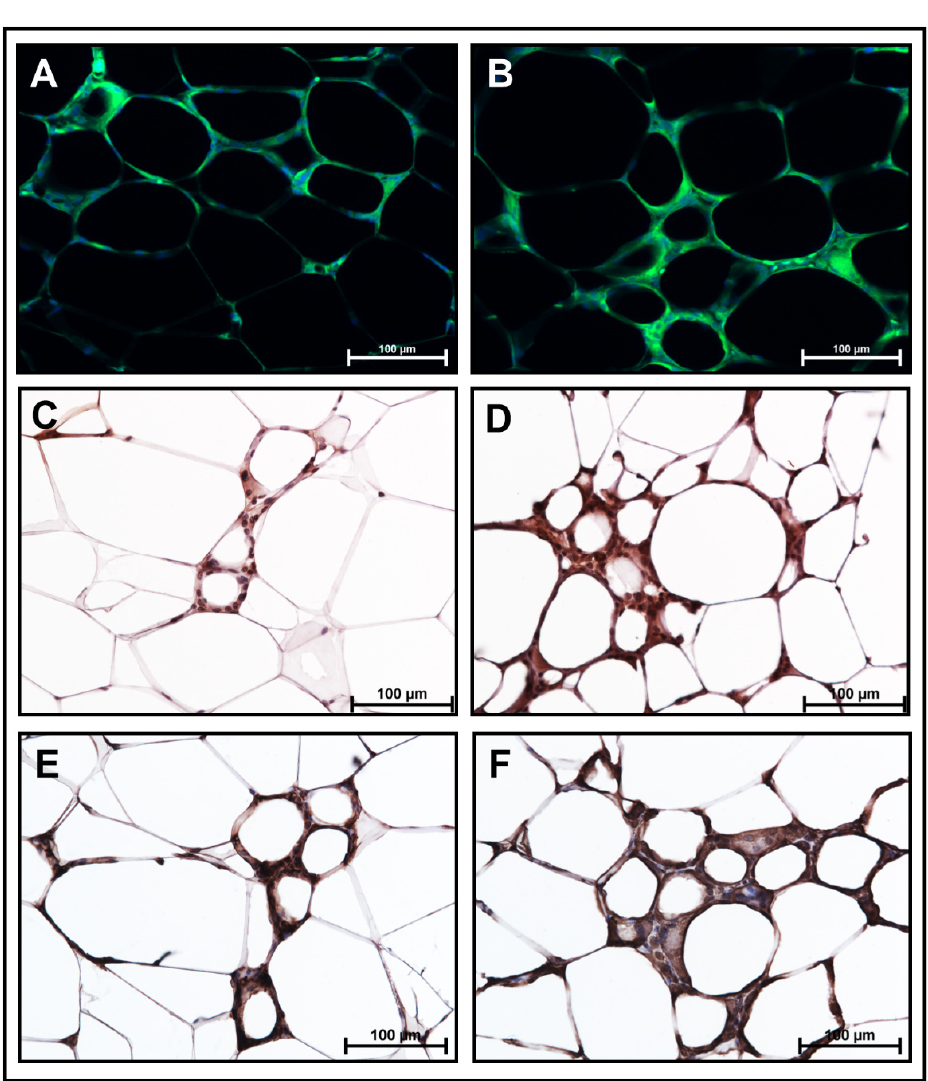
Figure 5. Immunostaining of VAT sections from HF and HF+MA-fed mice for macrophage and inflammatory markers. VAT sections from HF and HF+MA-fed mice were stained for F4/80 ( A , B ), MCP1 ( C , D ), and MIP1 α ( E , F ). Images were captured at 20 × magnification using the Nikon Eclipse 80i microscope. HF, high fat; HF+MA, high fat + myristic